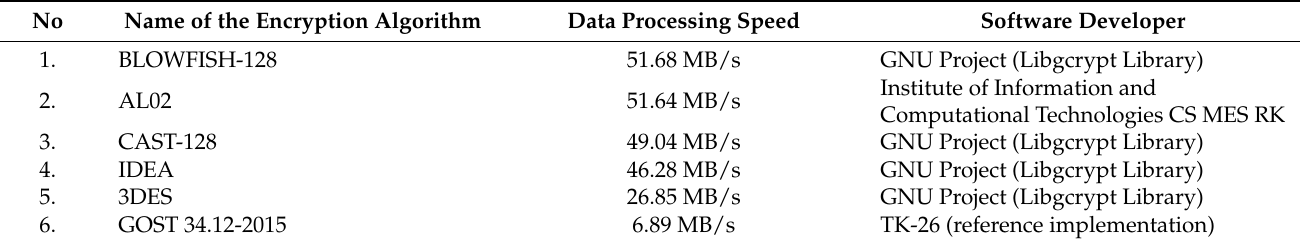
Table 5. Comparative performance characteristics of encryption